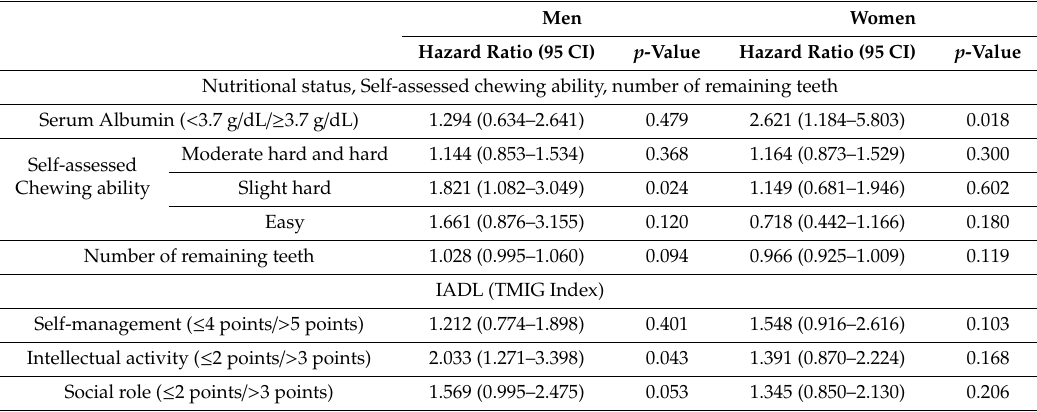
Table 3. Hazard ratios of nutritional status, self-assessed chewing ability, and